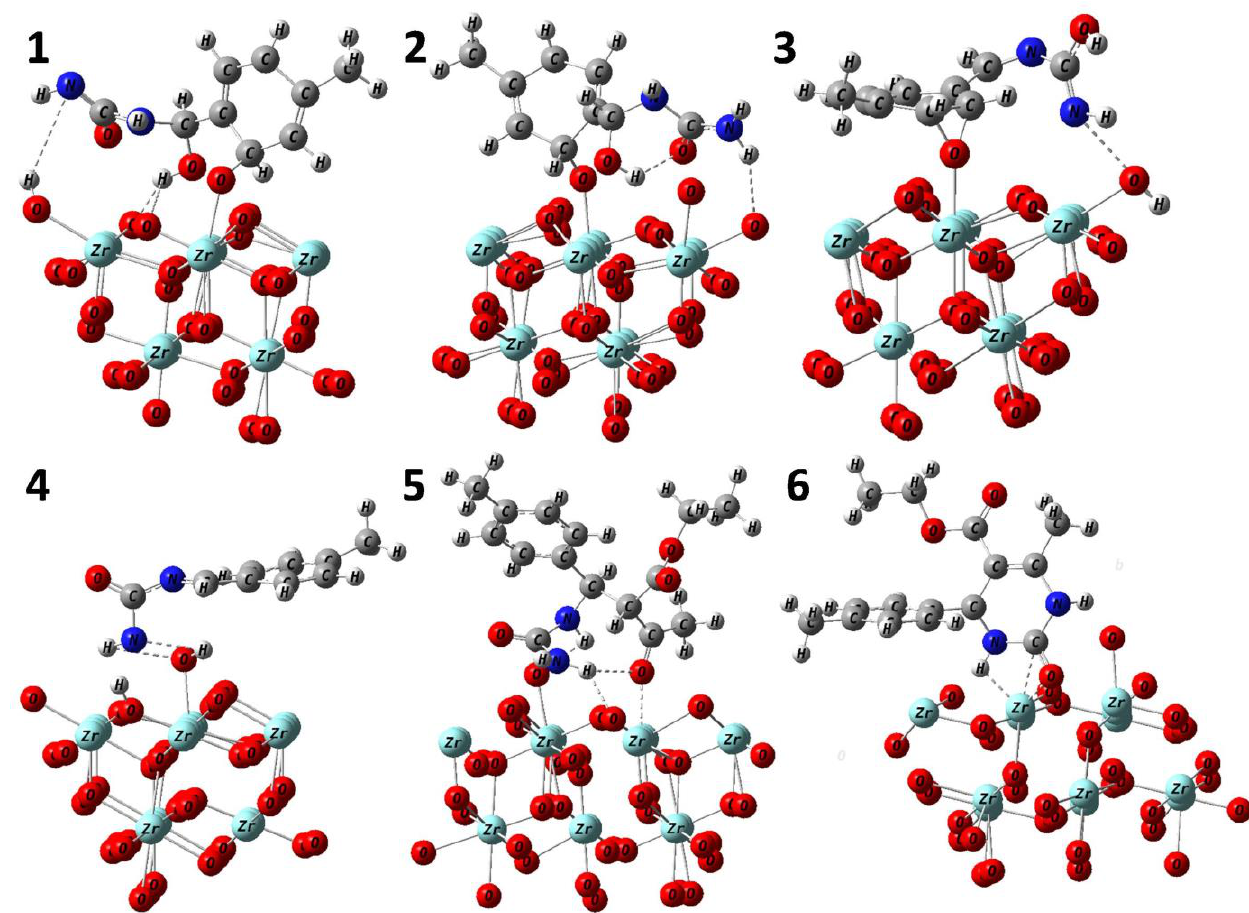
Figure 2. Optimized geometries of the surface-adsorbed molecules 1 – 6 .